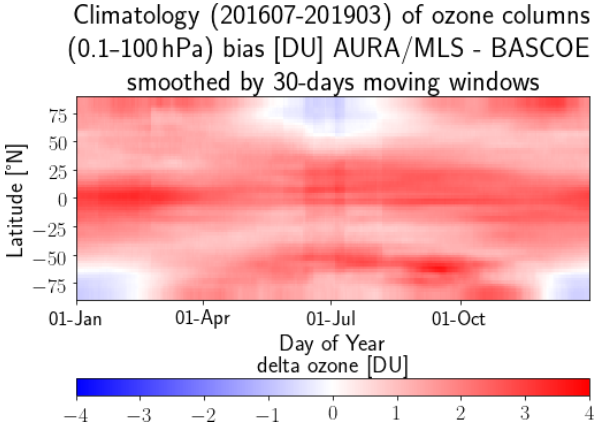
Figure 2. Time–latitude stratospheric ozone column bias climatol- ogy between MLS and BASCOE used to correct the BASCOE-FD stratospheric column. Table 1. Mean difference and standard deviation of S5P-BASCOE relative to the individual datasets Deviation S5P_CCD OMPS-MERRA-2 Sondes DU − 0 . 91 ± 5.76 3.34 ± 7.64 2.6 ± 9.3 % − 0 . 82 ± 21.71 14.59 ± 32.51 12.8 ±